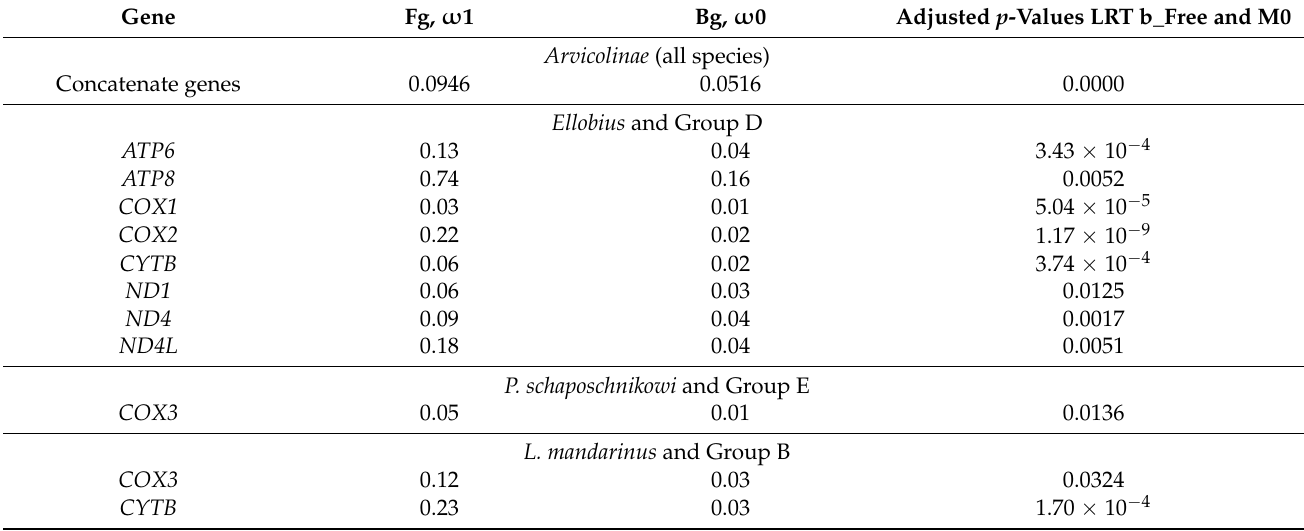
Table 1. Estimation of ω in ete-toolkit using a branch model. Fg-foreground branch (subterranean species), Bg-background branch (aboveground species). Subterranean species indicated by color on Figure 1. LRT-likelihood ratio test p -value for models’ comparison, M0-one-ratio model, b_fee-free-branch model. Only significant results are given in this table; all values can be found in Table